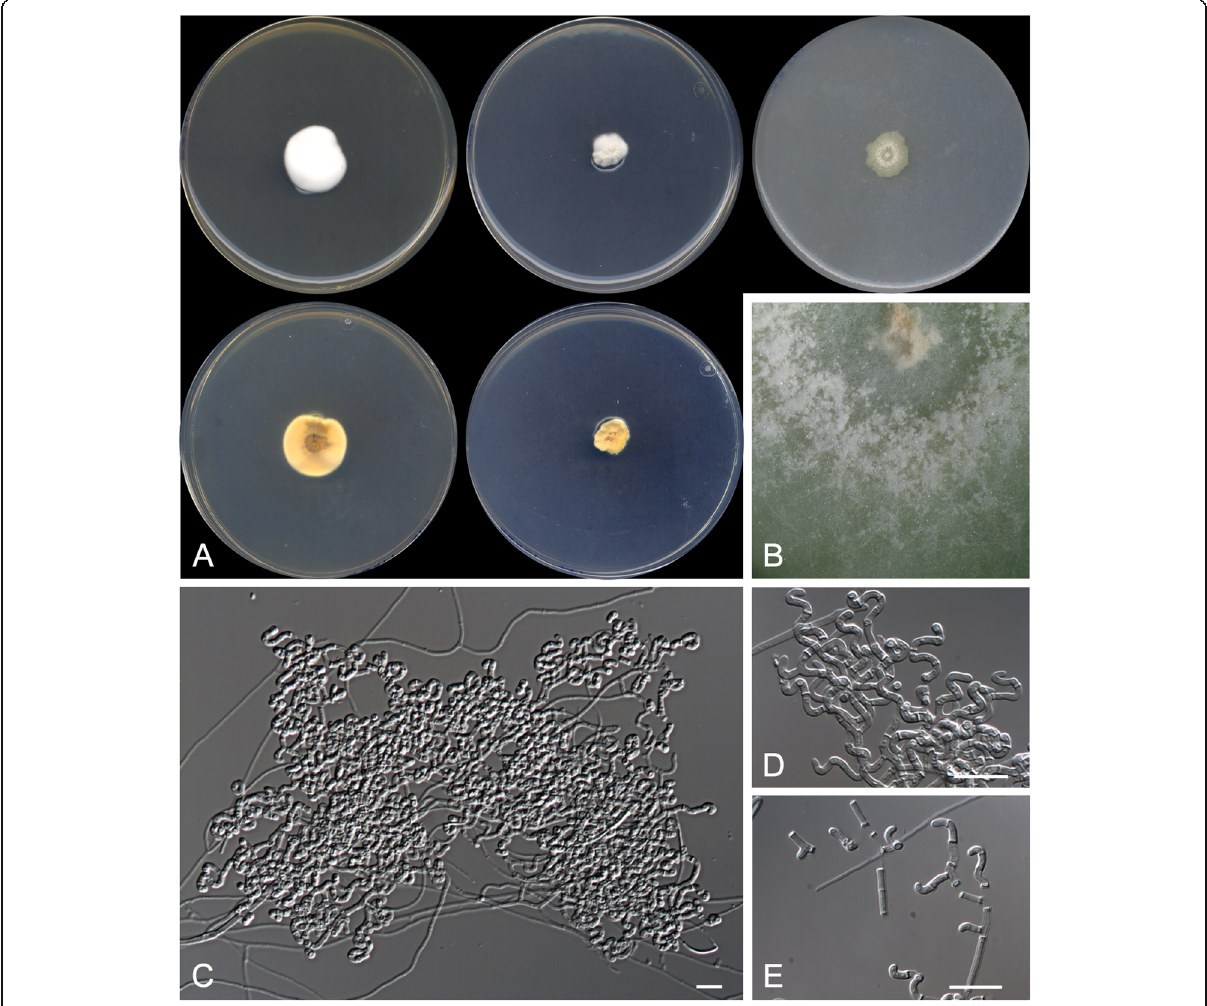
Fig. 3 Arachnomyces bostrychodes CBS 146926 T . a Colonies on PYE, PDA and OA after 14 d at 25 °C, from left to right (top row, surface; bottom row, reverse). b Detail of the colony on OA. c , d Sinuous, contorted to coiled fertile hyphae. e Arthroconidia. Scale bar = 10 μ